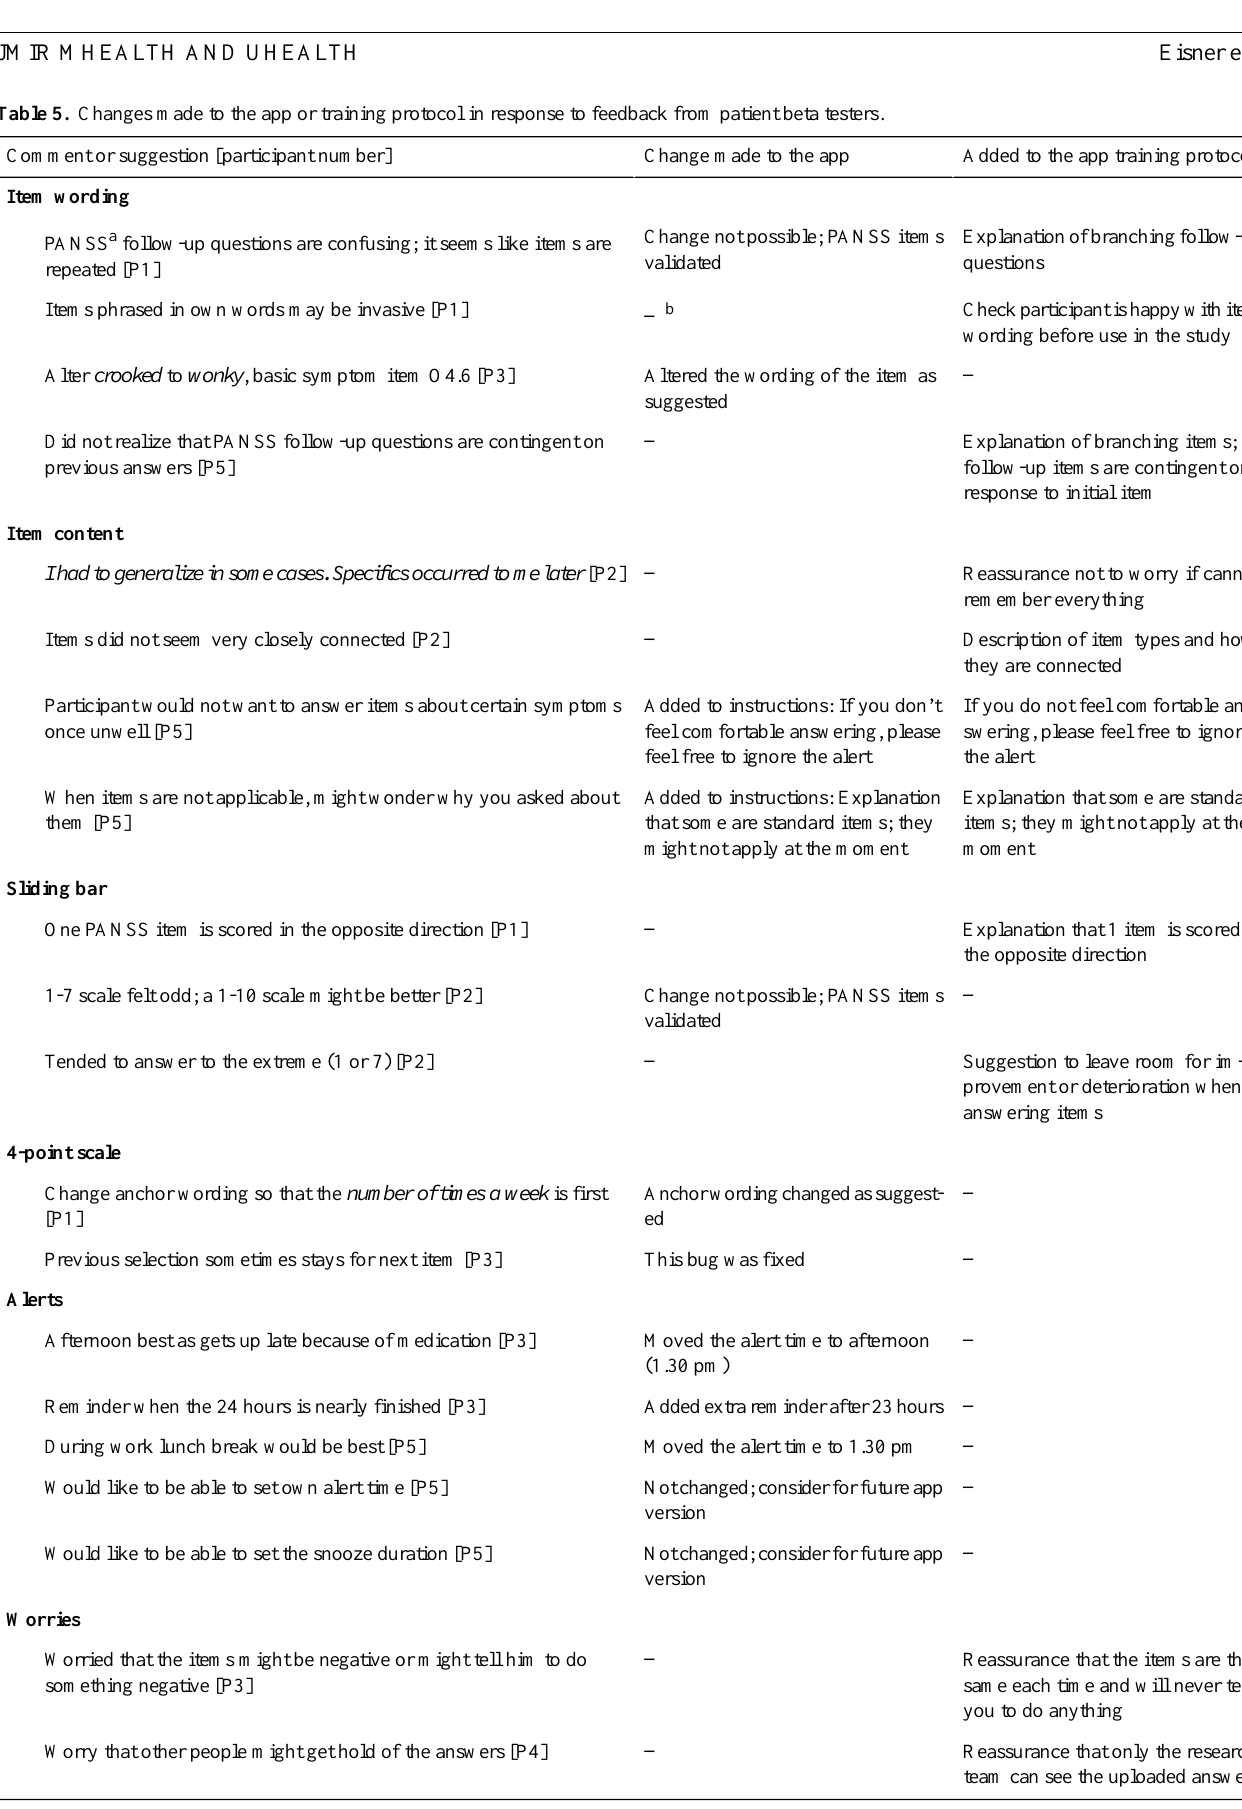
Table 5. Changes made to the app or training protocol in response to feedback from patient beta testers.